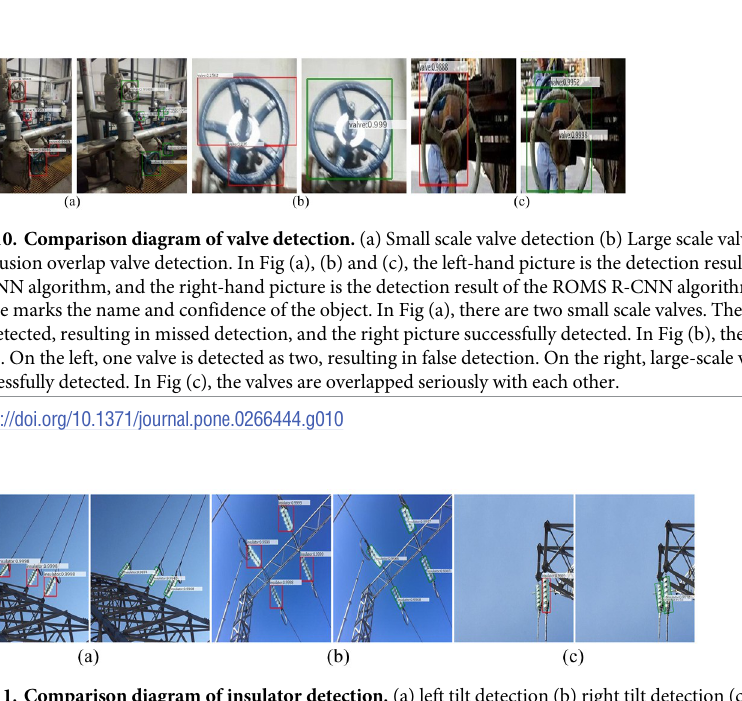
Fig 11. Comparison diagram of insulator detection. (a) left tilt detection (b) right tilt detection (c) occlusion overlap detection. In Fig (a), (b) and (c), the left-hand picture is the detection result of the Faster R-CNN algorithm, and the right-hand picture is the detection result of the ROMS R-CNN algorithm. The insulator in Fig (a) tilts to the left. In Fig (b), the insulator tilts to the right. The prediction box on the left is horizontal and the prediction box on the right is tilted. In Fig (c), insulators are slightly shielded. One insulator object is missing in the left picture, and two insulator objects are successfully detected in the right picture.